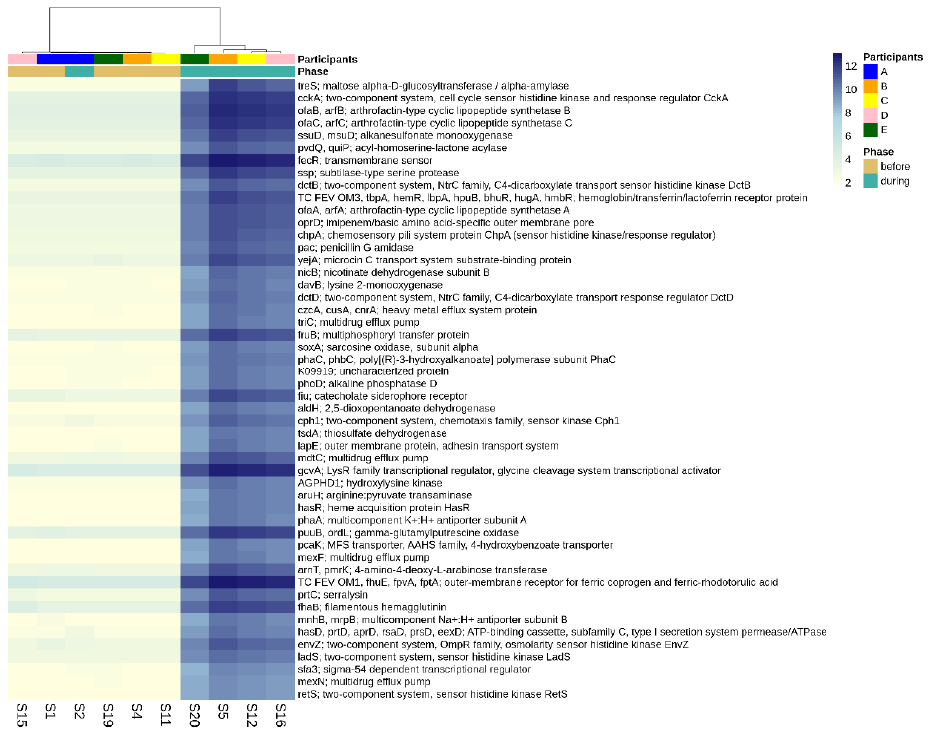
Figure 5. Differential abundance of functional genes comparing pre-infection microbiomes to those disturbed by norovirus-associated AGE. The first-row color scale indicates the participant numbers. The second row shows the phase of sample collection; before or during AGE. Numbers following “S” indicate the sample identifier for metagenomic data. Figure shows the top 50 differentially abundant genes with highest log2-fold change during disturbance ( p -adj < 0.05). There was a total of 3499 differentially abundant KO genes detected at the p -adj < 0.05